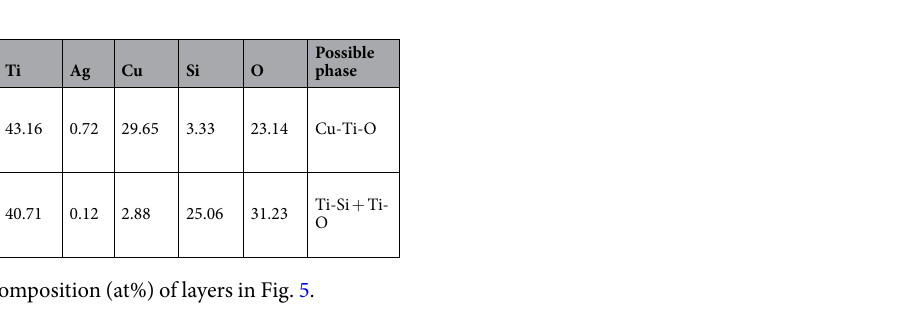
Figure 5. Microstructure of the AgCuTi-SiO 2f /SiO 2 wetting interface: ( a , c ) without VFG decoration; ( b , d ) with VFG decoration.